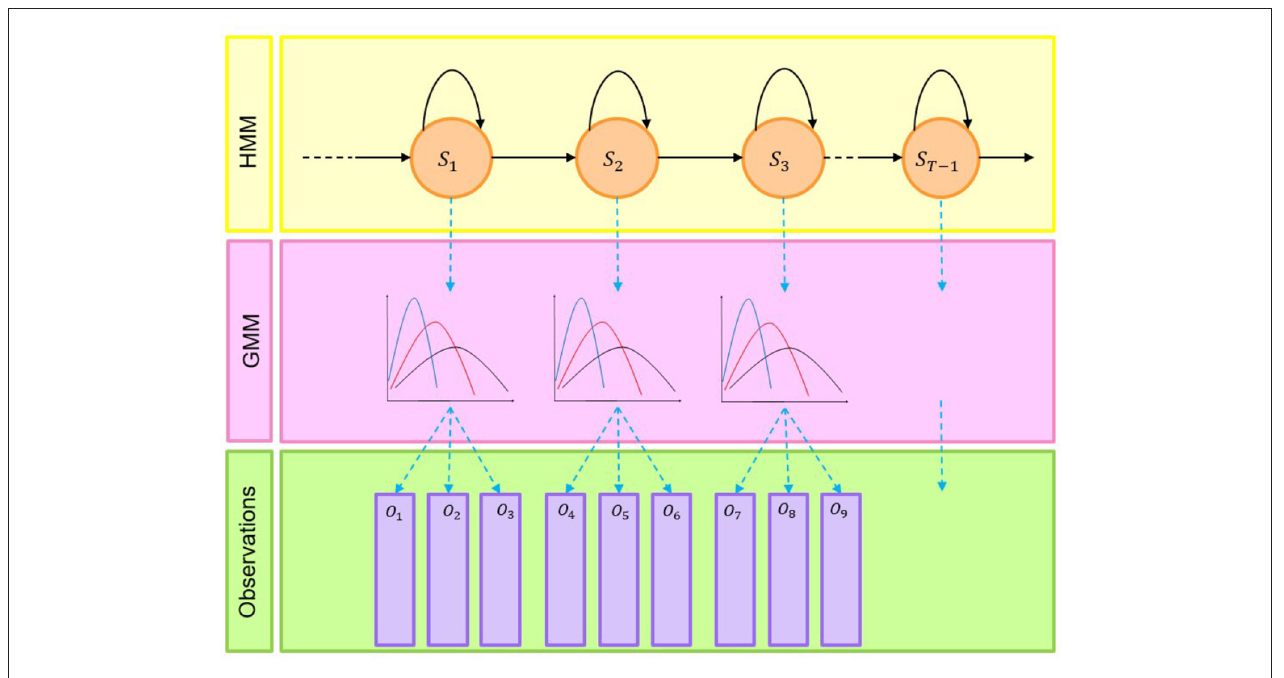
FIGURE 4 | Architecture of GMM-HMM.